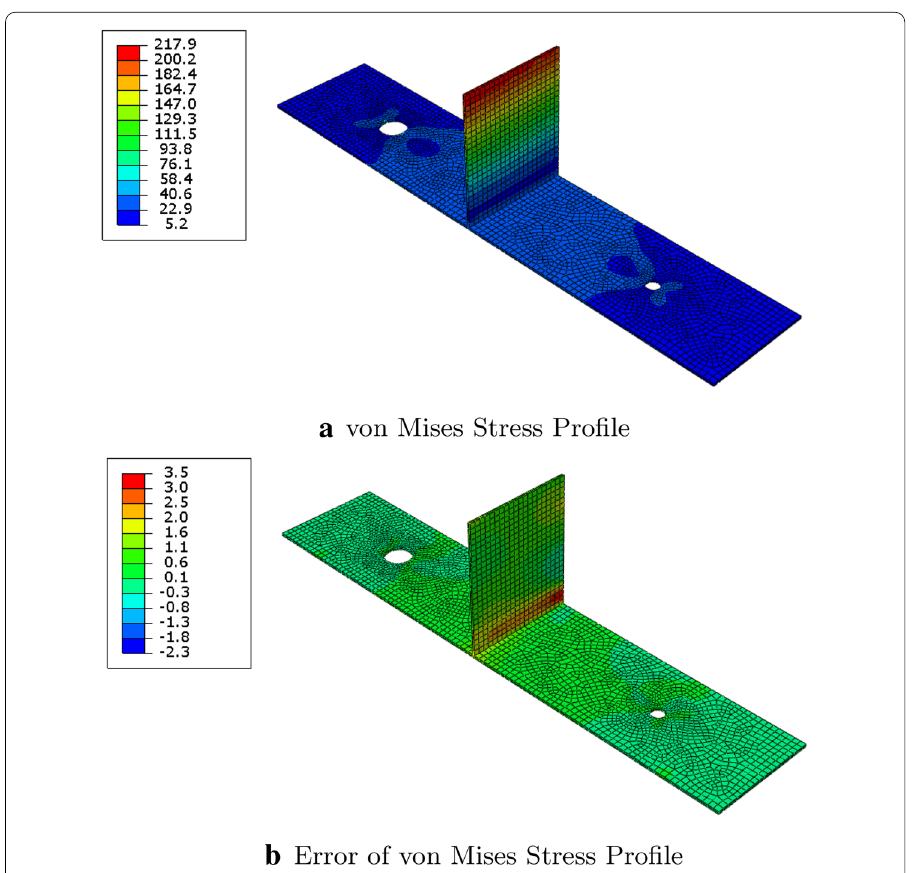
Fig. 7 Initial design feature model results in